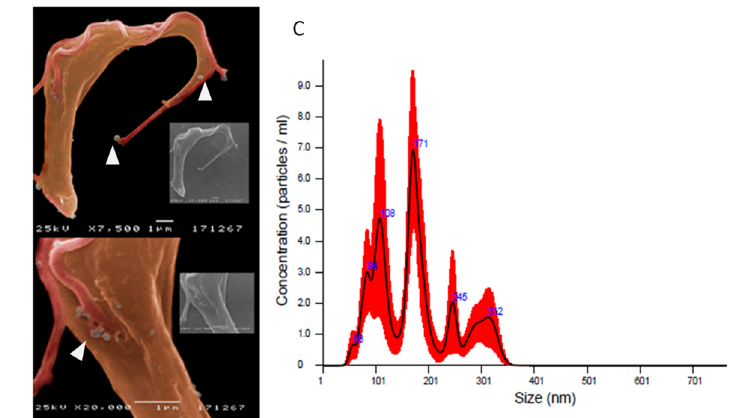
Figure 2. Release of extracellular nanovesicles by T. b. brucei and size and concentration of purified TbEVs. Representative images ( A , B ) of culture-derived parasites shedding nanovesicles (arrowheads) were acquired by SEM. TbEVs harvested from supernatants of T. b. brucei cultures were analyzed by NTA ( C ). Mean values (blue) + SD (red) are represented by average finite track length adjustment (FTLA) concentration/size graph.